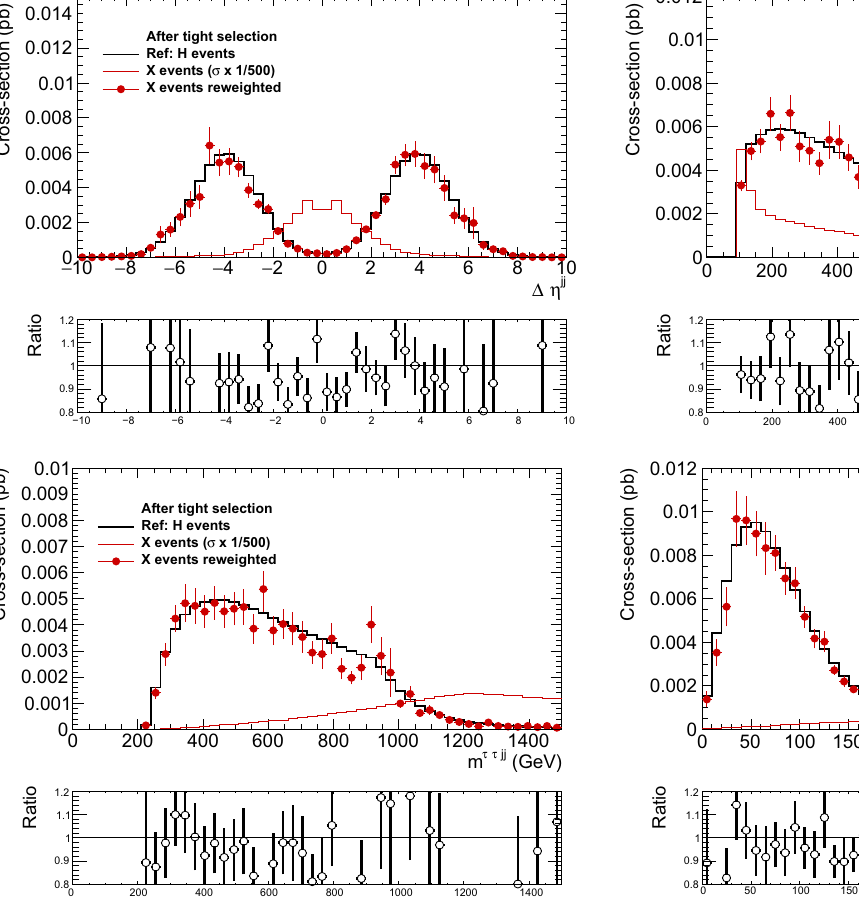
Fig. 4 The X sample re-weighted to the H and compared with the H much larger than for the case of Fig. 3. This is predominantly due to small acceptance of the X sample: 1.7% only. But the agreement with sample. The H and X widths are 5.75 MeV. Selection cuts: invariant the reference distribution (black histogram) remains within statistical mass of outgoing particles m ττ jj < 1500 GeV, invariant mass of jets < 600 GeV. Note that statistical fluctuation (dominated by large weight events). Variables on the x -axes system 100 < m jj < 800 GeV and p ττ T as explained in Sect. errors for the distributions obtained with re-weighting (red points) are